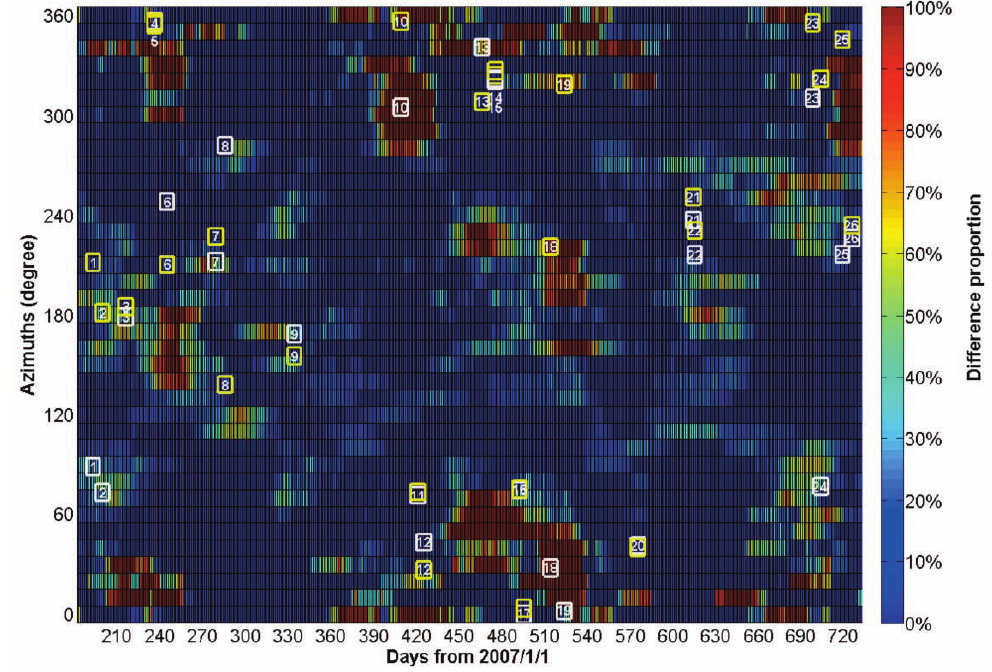
Figure 5. The difference proportion distribution. Blue to red indicate the distint difference proportions. White and yellow rectangles show the larger realtionships between the difference proportions and the azimuths of the 26 epicenters, and the SMART versus the midpoint, respectivley. The widths of the rectangles indicate a temporal period over –10 to 0 days to the